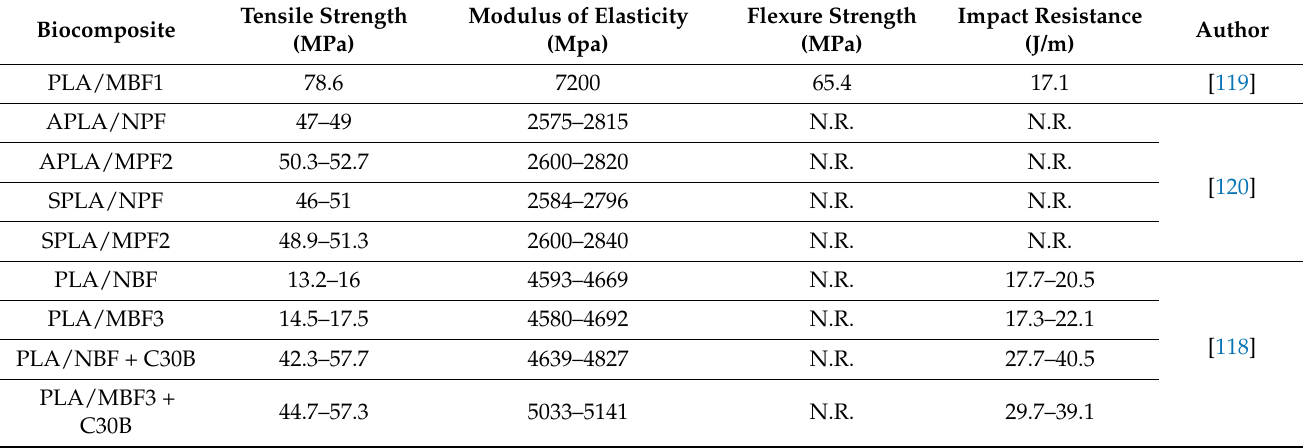
Table 10. Mechanical properties of PLA-based